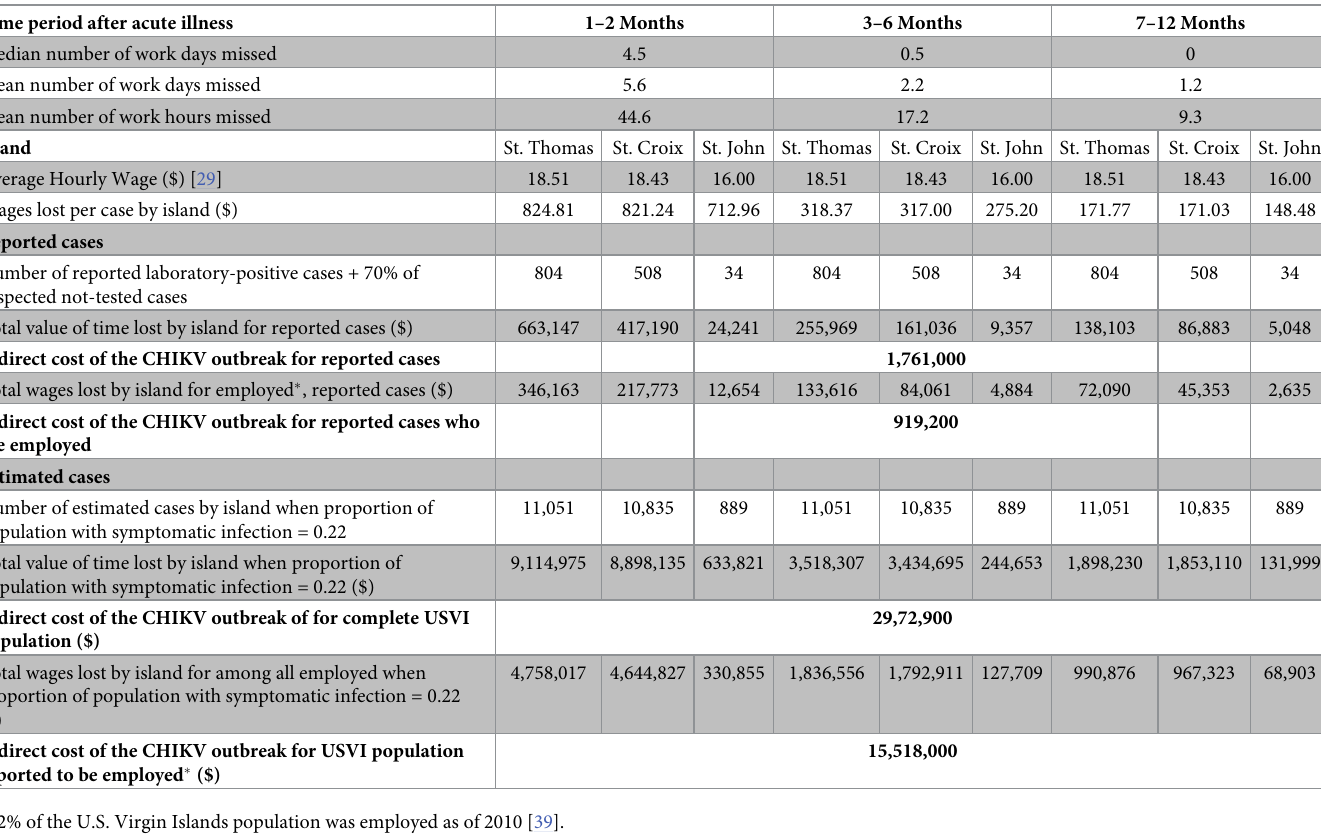
Table 2. Indirect cost estimates (2014 USD) due to absenteeism from the chikungunya outbreak in the U.S. Virgin Islands up to 12 months after disease